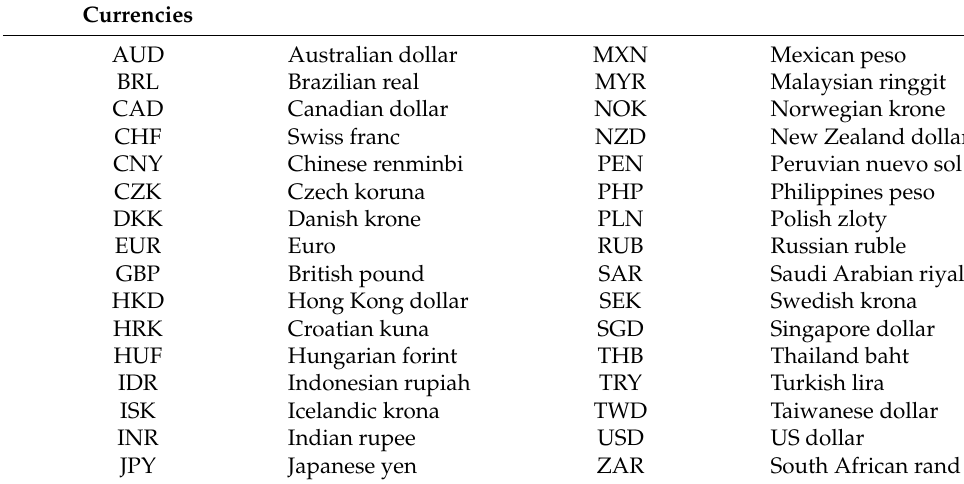
Table 1. List of abbreviations of the considered